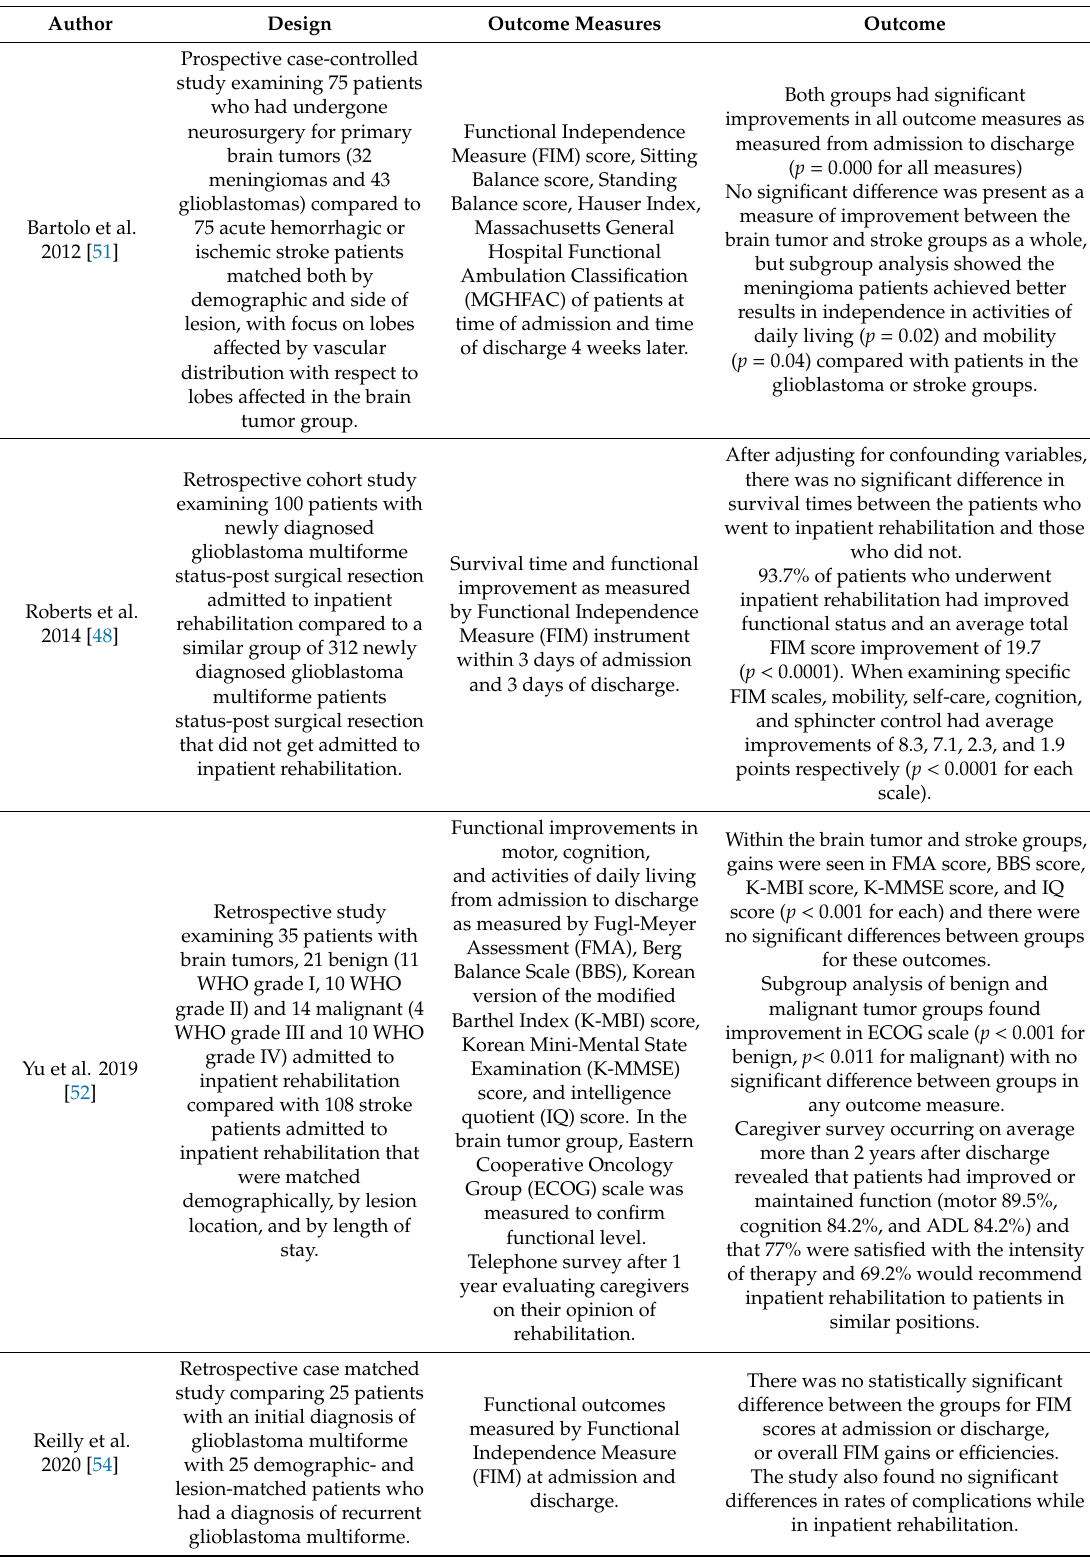
Table 2. Comparison of inpatient rehabilitation for patients with primary brain